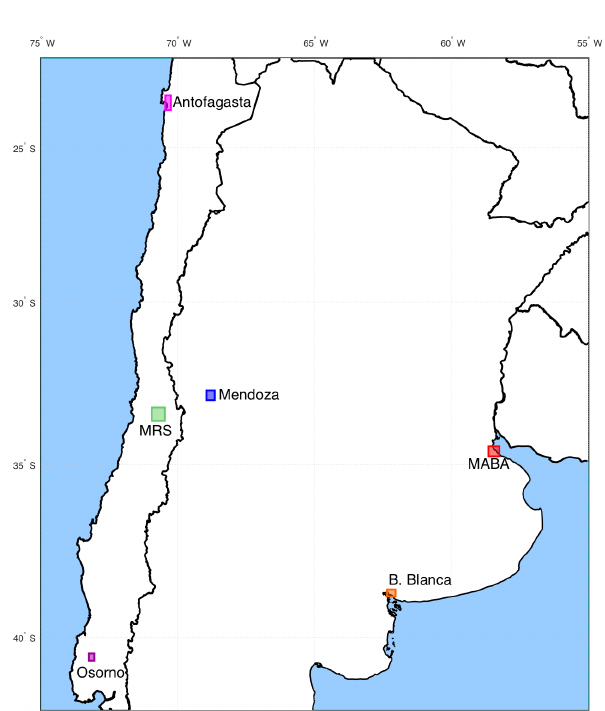
Earth Syst. Sci. Data, 14, 271–293, 2022